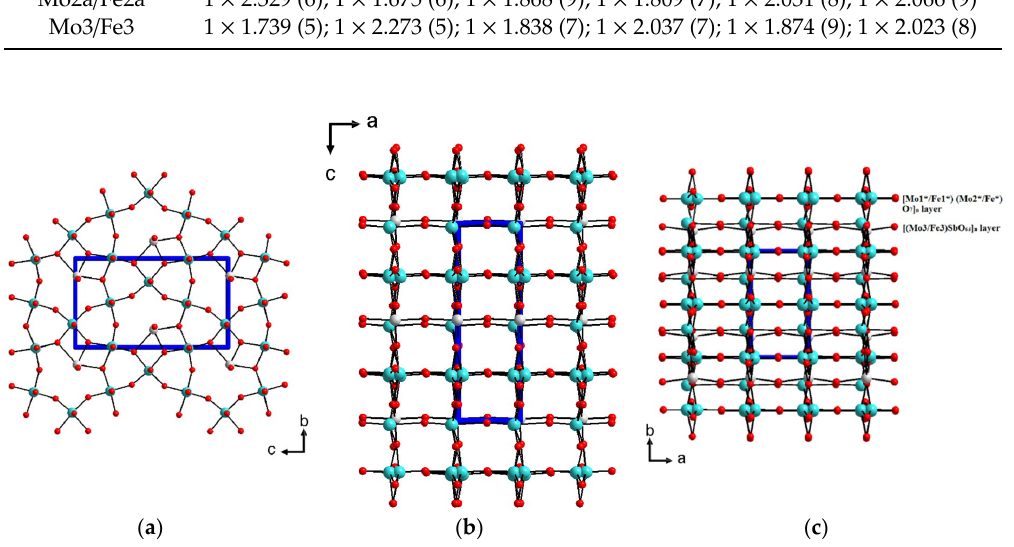
Figure 3. Overview of the crystal structure of Fe 0.43 Mo 2.56 SbO 9.5 along ( a ) [100], ( b ) [010], ( c )[001] respectively.(Mo*/Fe*) = light blue, Sb = Grey, O = Red. Table 3. Interatomic distances/Å in Fe 0.43 Mo 2.56 SbO 9.5.